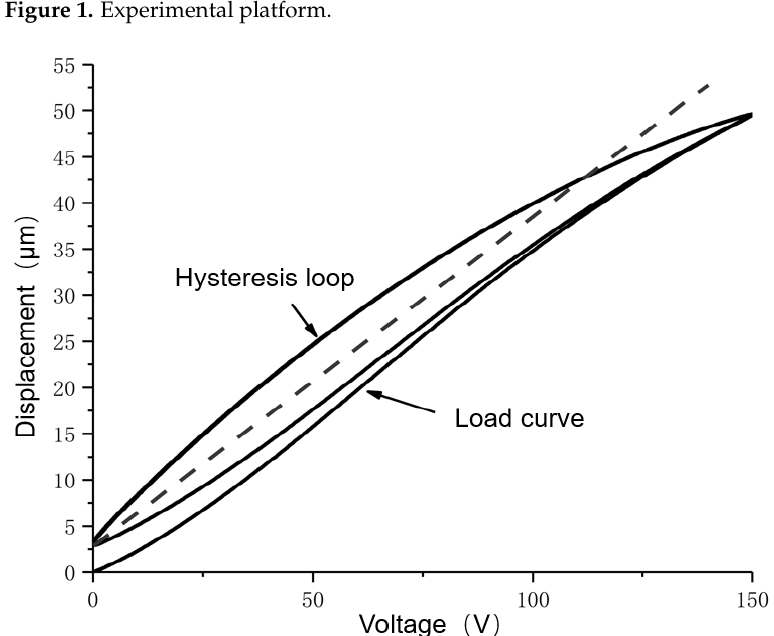
Figure 2. Hysteresis graph.